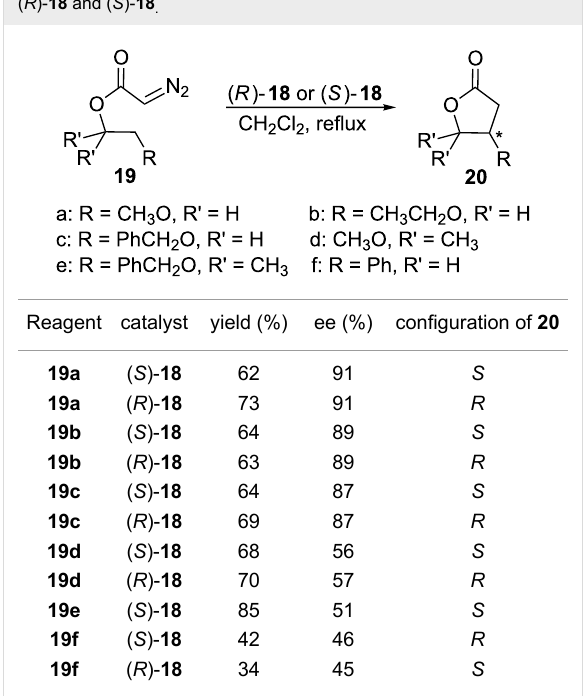
Table 2: Enantioselective intramolecular insertion of carbenoids into C(sp 3 )–H bonds catalyzed by rhodium (II) carboxamides complexes ( R )- 18 and ( S )- 18